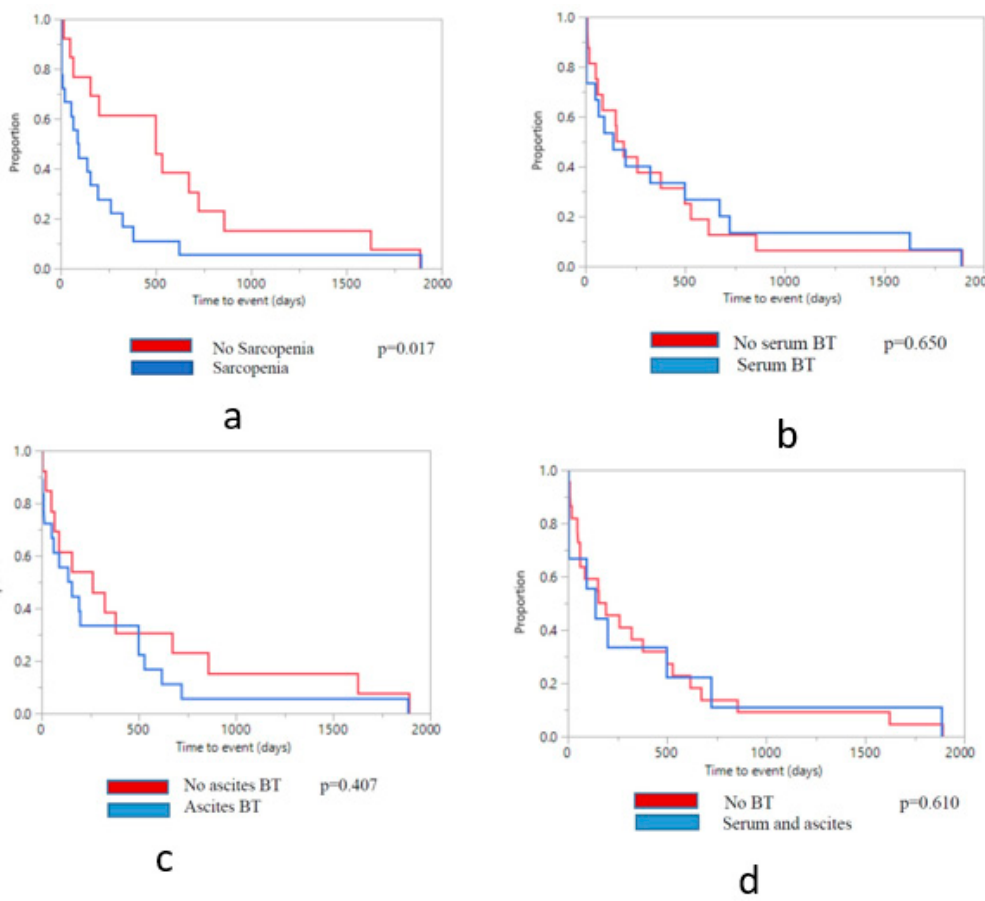
( a ) According to sarcopenia status; ( b ) According to bacterial translocation (BT) status in serum only; Figure 2. Kaplan-Meier curve for time to the event, including transplant, death or loss to follow-up. ( c ) According to BT status in ascites only; ( d ) According to BT status in both serum and (a) According to sarcopenia status; (b) According to bacterial translocation (BT) status in serum only; (c) According to BT status in ascites only; (d) According to BT status in both serum and AF.